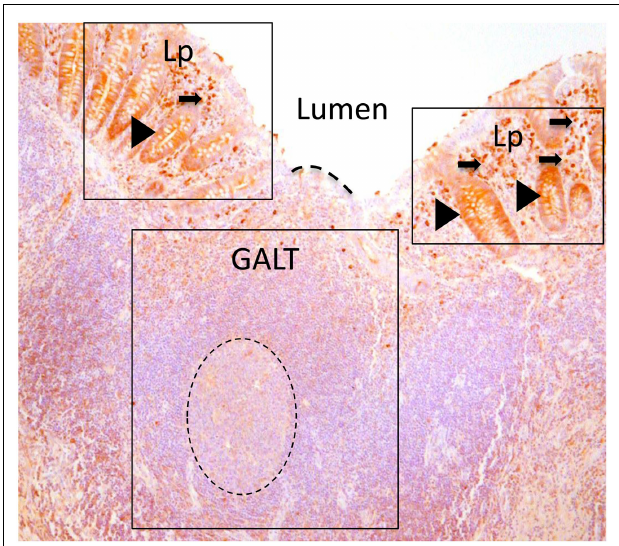
FIGURE 1 | Paraffin sections of human appendix stained to detect IgA (brown). Gut-associated lymphoid tissue (GALT) is boxed. GALT is comprised mostly of B cells and contains a prominent germinal center of dividing B cells (dotted circle).The epithelial barrier between the GALT and the intestinal lumen, marked with a dotted line, is the FAE. Lamina propria (Lp) is boxed either side of GALT.The lamina propria includes abundant effector cells including plasma cells (arrowed) Unlike the epithelium adjacent to GALT, crypt epithelium of the lamina propria contains IgA that is in the process of being transported to the intestinal lumen (arrow heads).